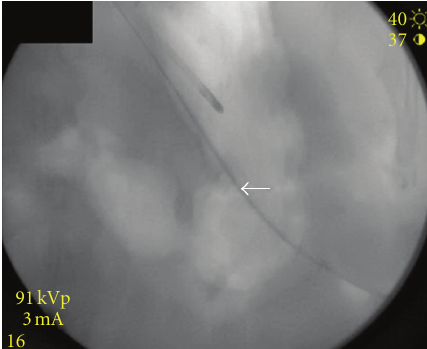
Figure 4: The guide wire (white arrow) directed into the gastric lumen and up the esophagus under fluoroscopic control.